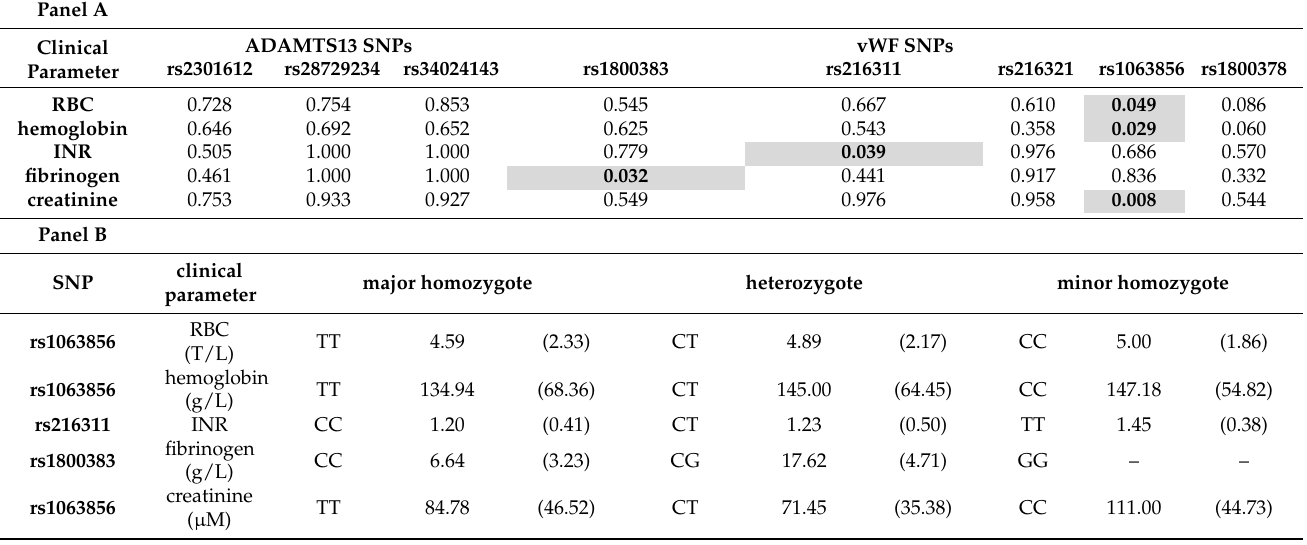
Table 6. Genetic association of certain laboratory parameters with polymorphisms. Panel A. p values were calculated by ANOVA. Nominally significant ( p < 0.05) results are highlighted using a gray background. Only parameters with significant association are shown in the table. RBC: red blood cell count (T/L); INR: international normalized ratio. Hemoglobin and fibrinogen levels are shown in g/L, whereas creatinine concentrations are measured in µ mol/L. Panel B. Genotype–phenotype correlations of significant associations indicated in panel (A). Average levels and standard deviations (enclosed in brackets) of clinical parameters are shown in the context of each genotype